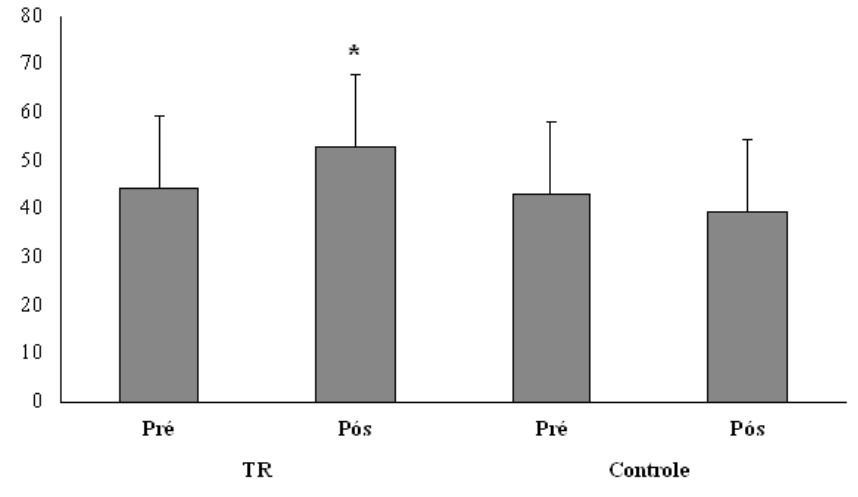
Figura 1. Medidas da área muscular do braço direito isenta de massa óssea (cm 2